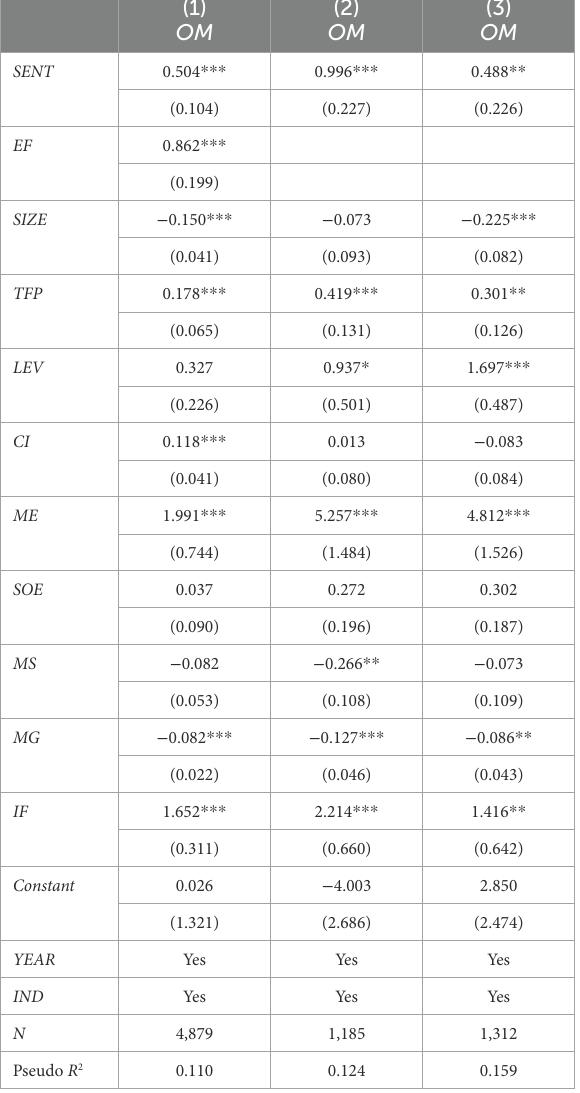
TABLE 5 Transmission channels